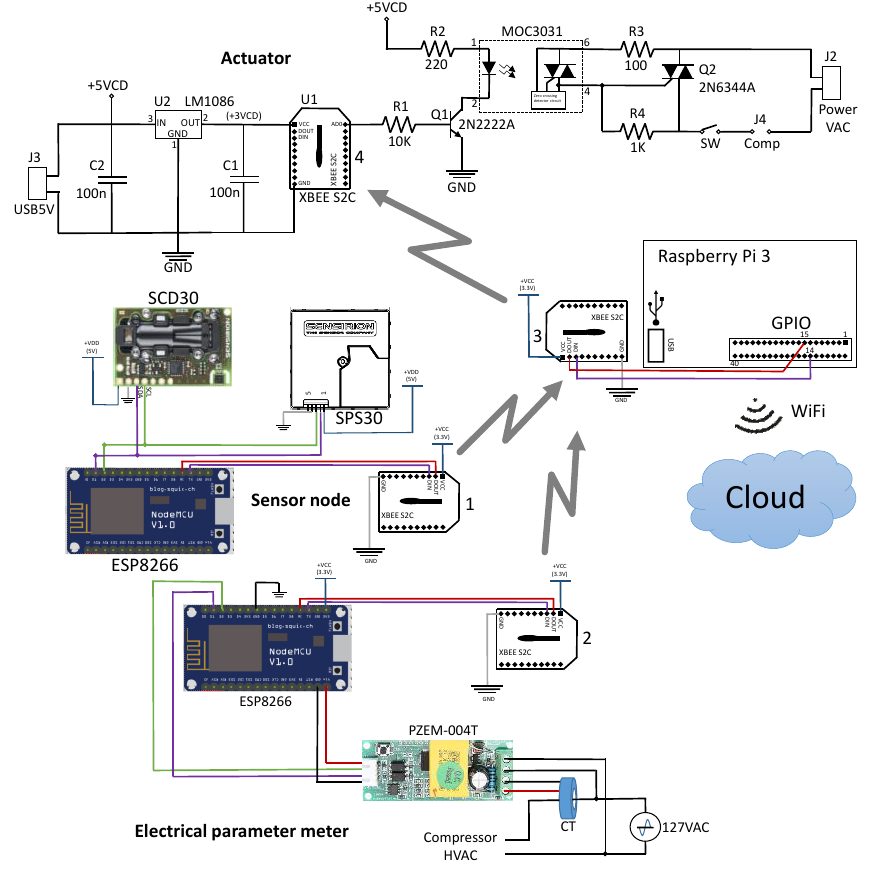
Figure 5. Control system circuit.